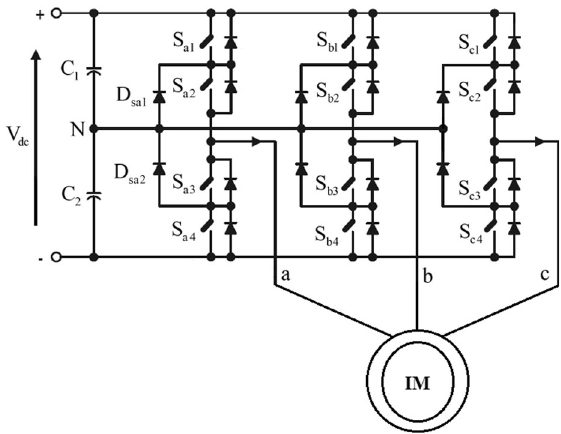
Fig. 5 Three-phase three-level inverter supplying an asynchronous